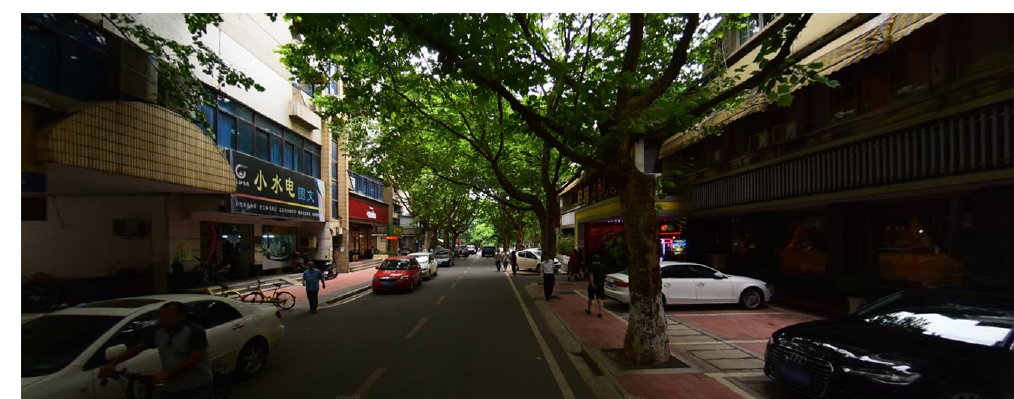
Figure 12. Test scene under the shade of trees.